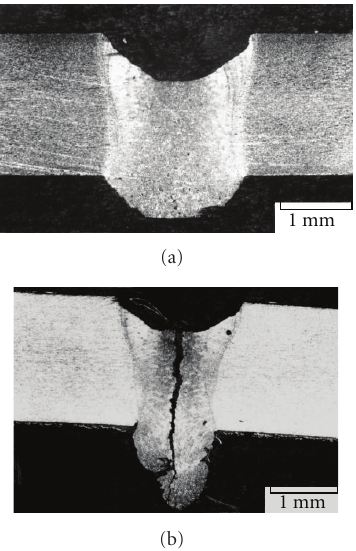
Figure 3: Fusion zone configuration of alloy AA5083 made using P = 4kW, Dd = 0, 15 l/min argon. (a) S = 4m/min, (b) S = 6m/min.